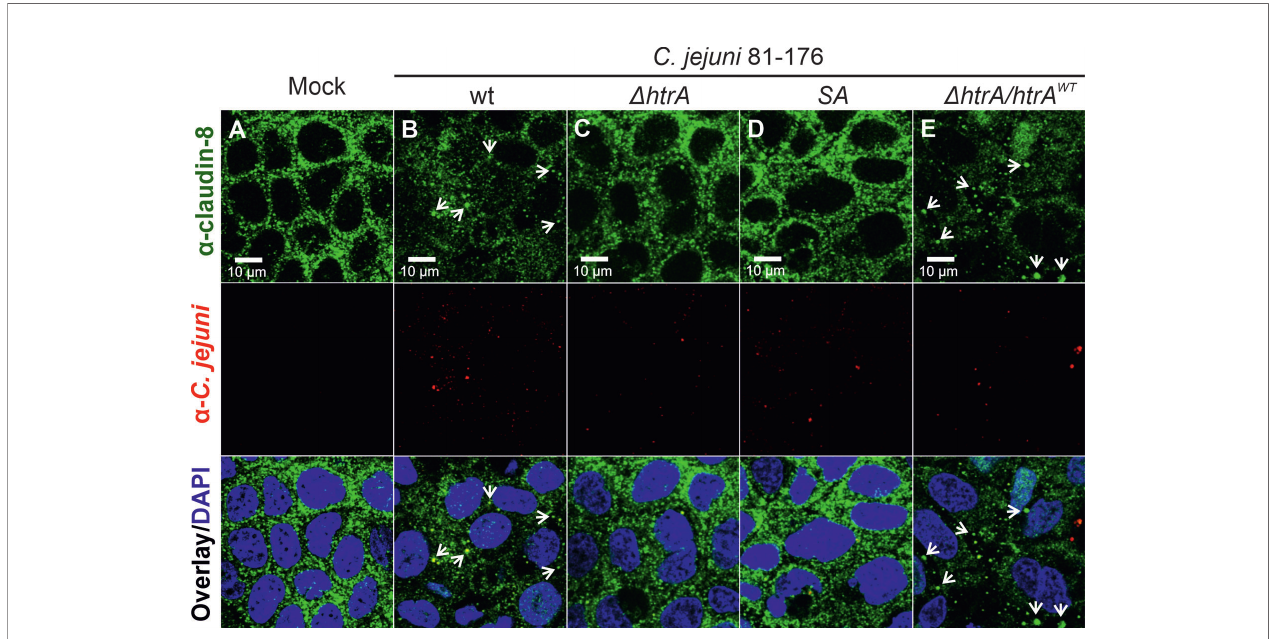
FIGURE 1 | Infection of polarized Caco-2 epithelial cell monolayers by C. jejuni 81-176 results in the disruption of claudin-8 patterns. Epithelial cells were immunostained with a - claudin-8 (green) and a - C. jejuni (red) without infection (A) , or after infection with C. jejuni wild-type (wt) strain (B) , D htrA knockout mutant (C) , D htrA complemented with protease inactive SA mutant (D) or wt htrA (E) . Infection was performed for 12 h at an MOI of 100. DAPI staining (blue) was used for the nuclear DNA counterstaining. White arrows indicate claudin-8 redistribution to